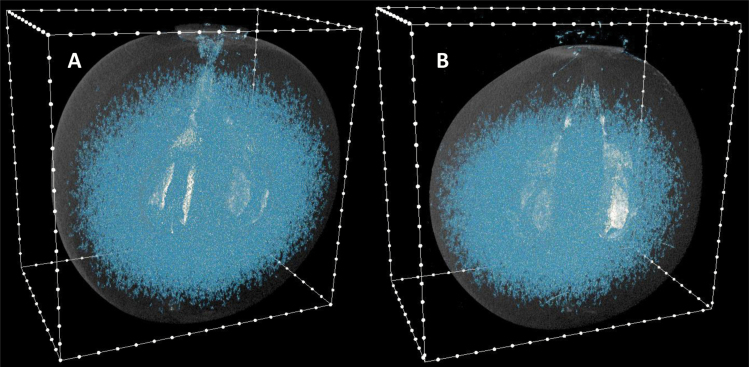
Air spaces in Chardonnay berries as determined by X-ray micro-CT. (A) At 98 DAA (19.3 °Brix) and (B) at 154 DAA (24.5 °Brix) in the 2015–2016 season. Images have been manipulated to indicate the berry outline. Minimum voxel cut-off was 500. White dots on the box outline are at 1 mm intervals.